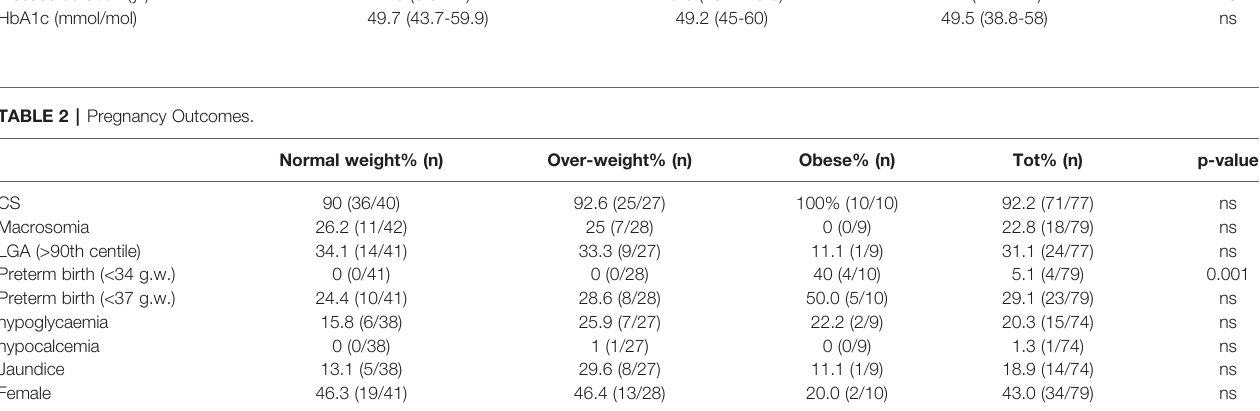
Normal weight n.